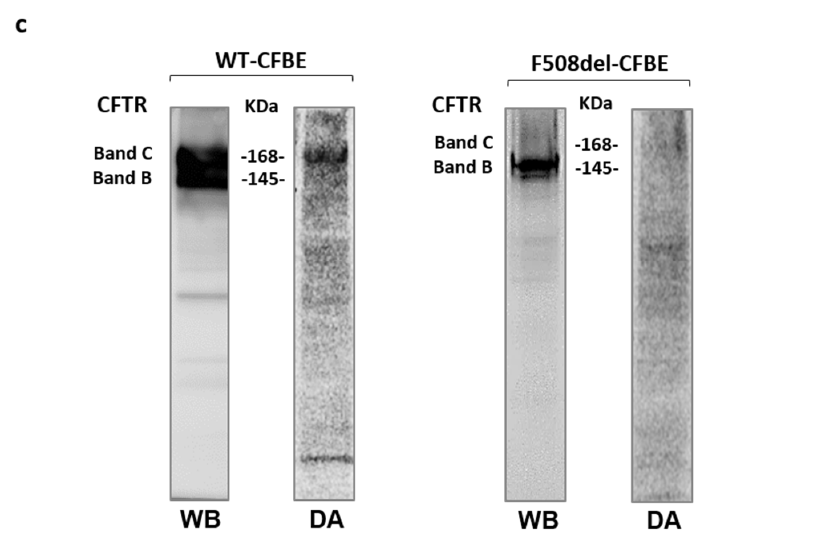
Figure 2. Ganglioside GM1 and CFTR reside in the same PM microenvironment. Chemical structure of the radioactive and photoactivable ganglioside GM1 derivative ( 3 H-GM1-N 3 ) ( a ) and schematic representation of its use in a photolabeling experiment. ( b ) CFBE41o − cells overexpressing the WT form of CFTR or F508del CFTR were treated with tracer quantity of 3 H-GM1-N 3 in dark conditions and, after 6 h, cells were illuminated under UV light, harvested and subjected to SDS-PAGE and immunoblotting analyses against CFTR (WB). The same PVDF membranes were then subjected to digital autoradiography (DA) to reveal the radioactivity associated with the proteins due to the cross link with the 3 H-GM1-N 3 ( c ).